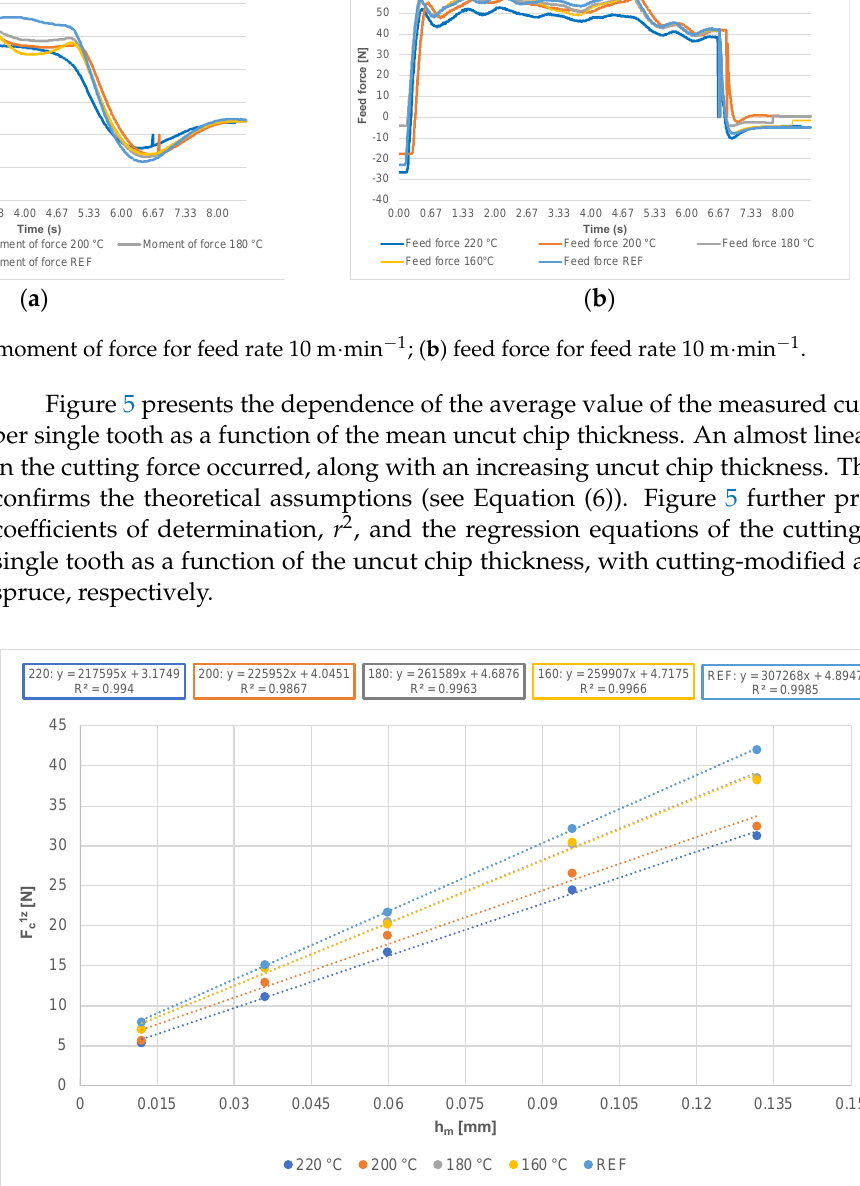
Table 3. ANOVA analysis: influence of temperature on the cutting force per single tooth.